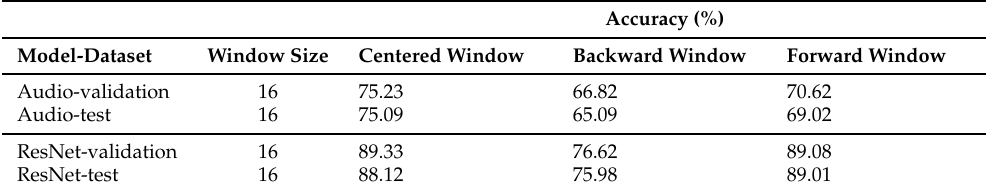
Table 3. Comparison of the accuracy of classification for different models on the validation and test sets, with respect to window